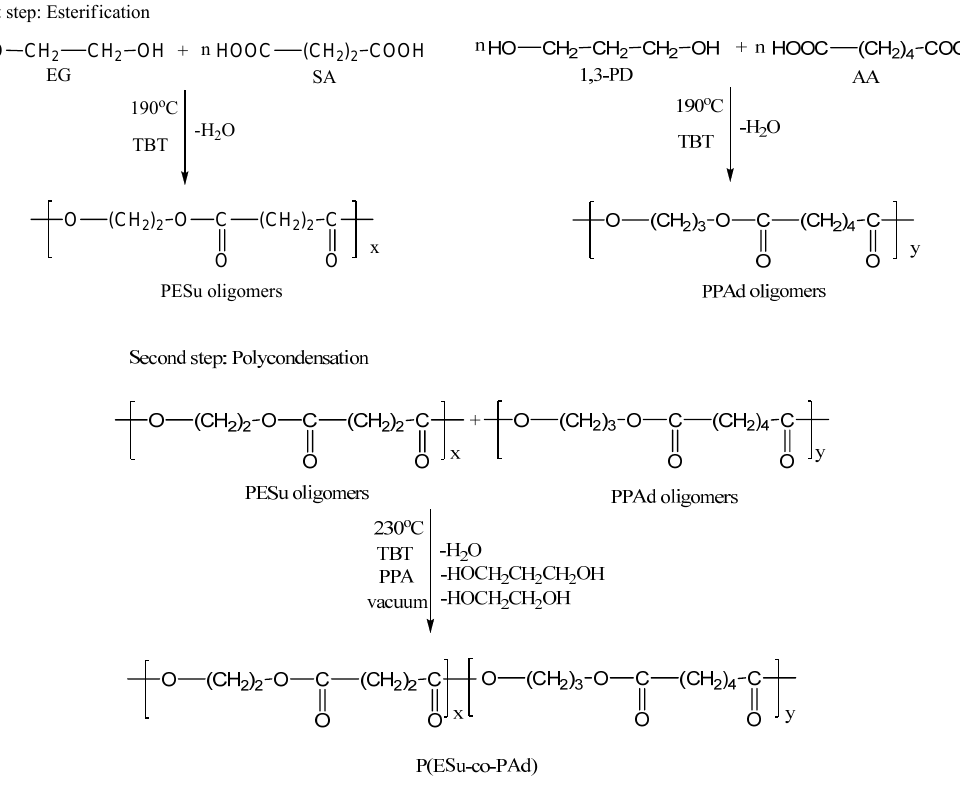
Figure 12. Synthetic route to P(ESu-co-PAd) copolymers preparation, via the two step